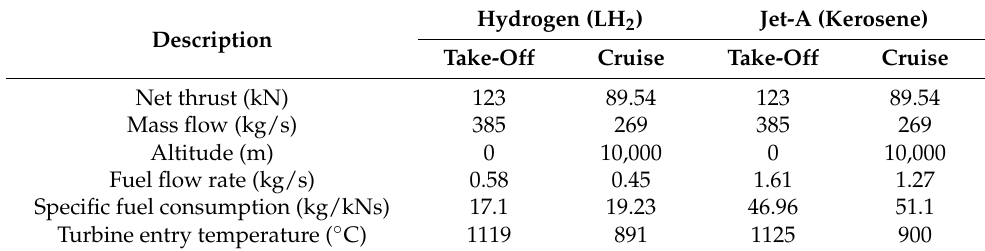
Table 5. Turbofan performance comparison of LH 2 and jet